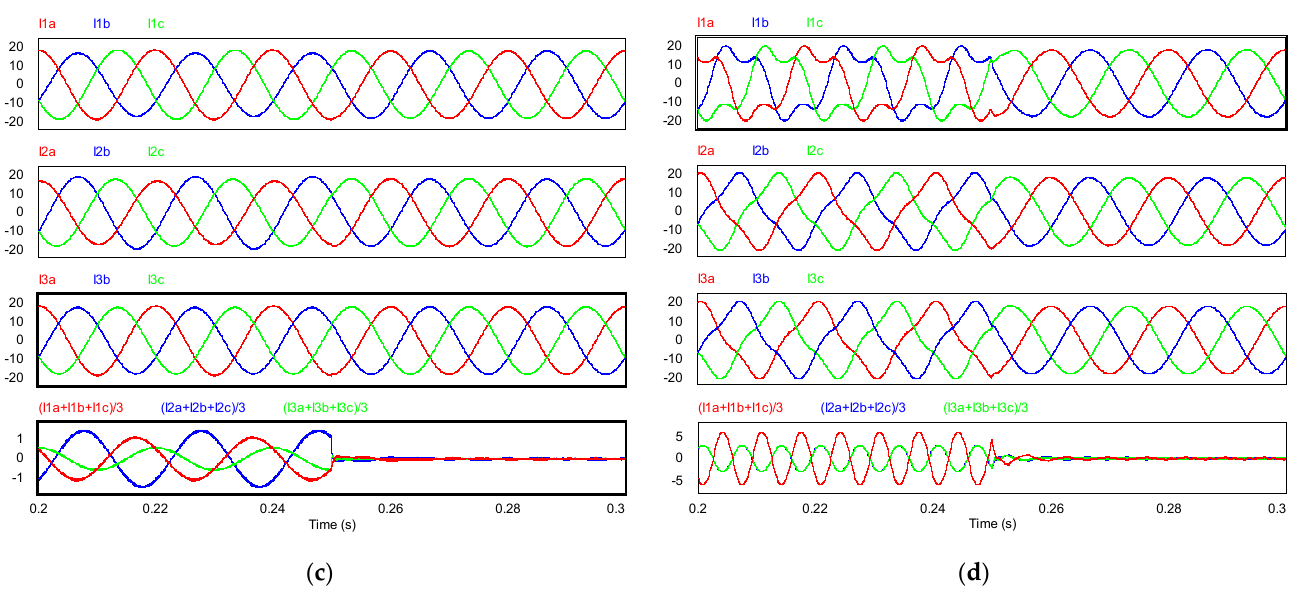
Figure 10. Simulation results of the control of the circulating currents among three inverters connected in parallel ( a ) with unbalanced inductances in both inverters, ( b ) with unbalanced load factor among inverters, ( c ) with unbalanced inductances in the same inverter, ( d ) with a different modulation in each inverter.